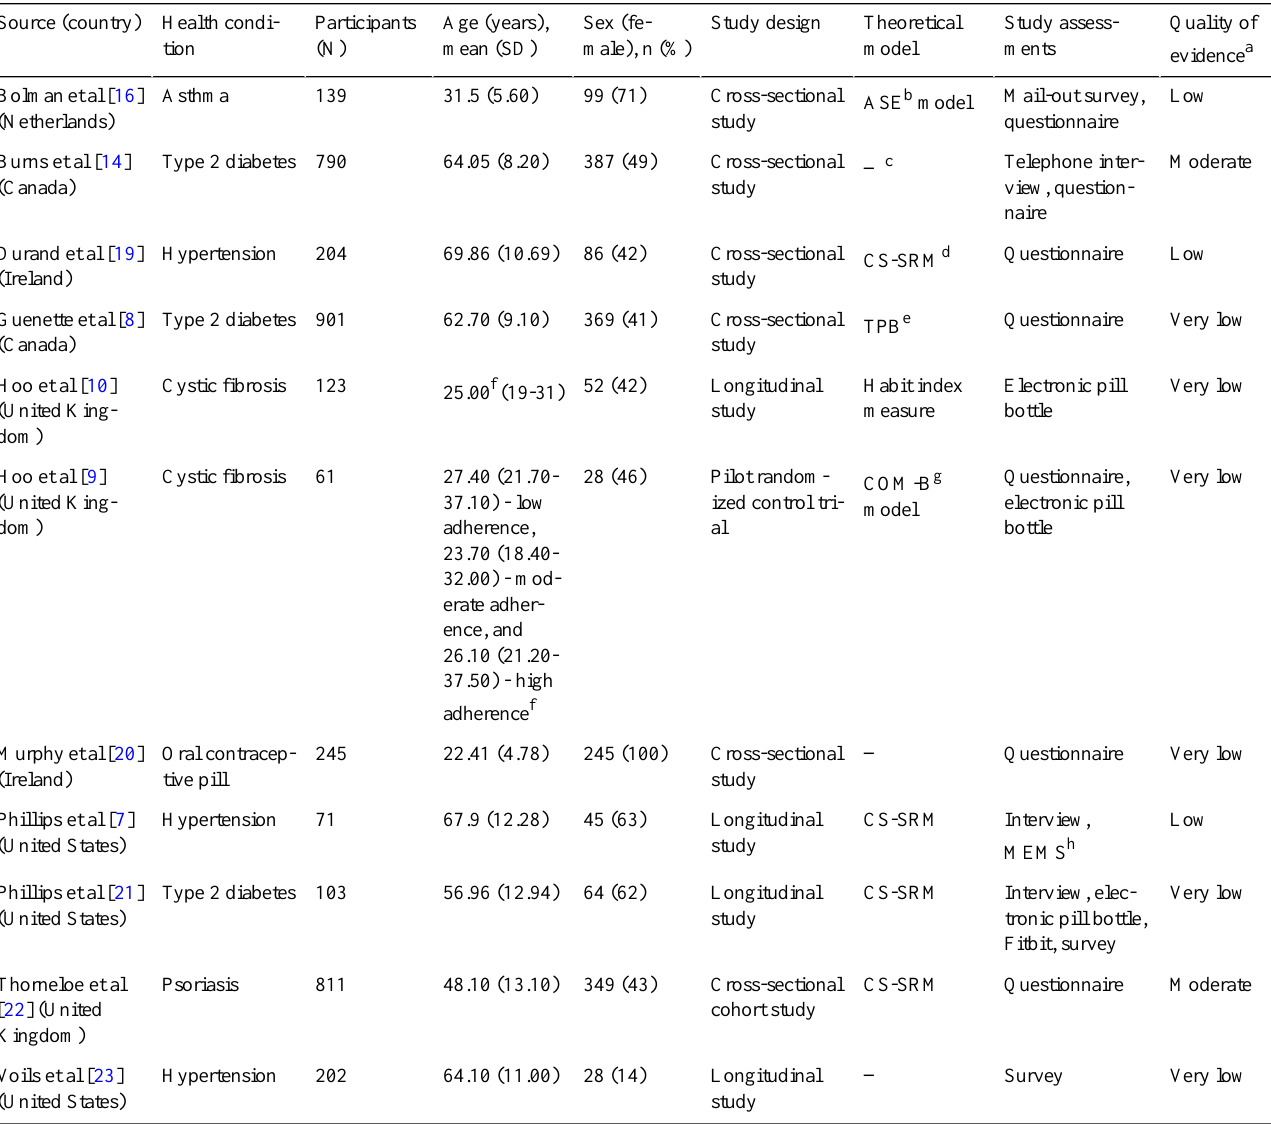
Table 1. Summary of included studies that evaluated habit strength and medication adherence.